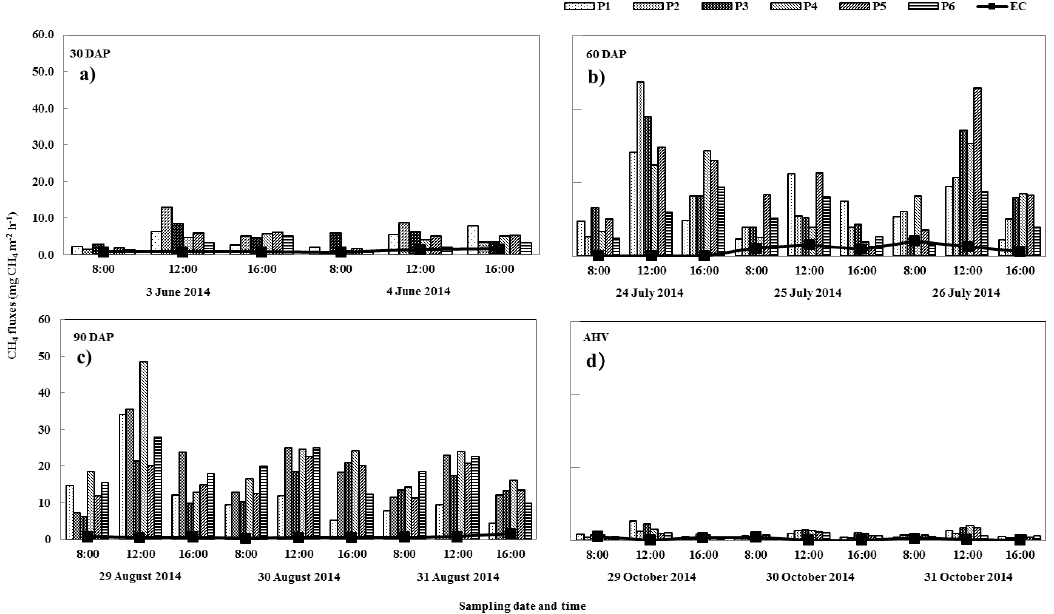
Figure 5. CH 4 fluxes measured with the closed chamber method (P1–P6) and the eddy covariance technique on ( a ) 30 DAT, ( b ) 60 DAT, ( c ) 90 DAT and ( d ) AHV.